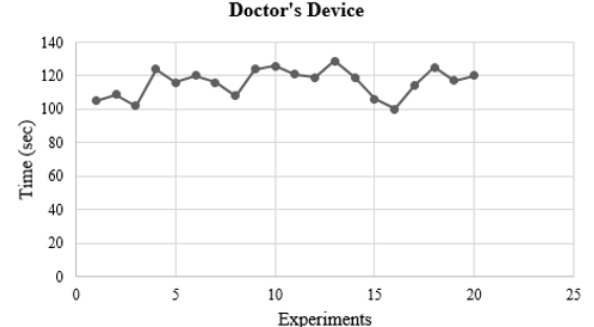
Figure 12. Alert Delivery time for Doctor’s